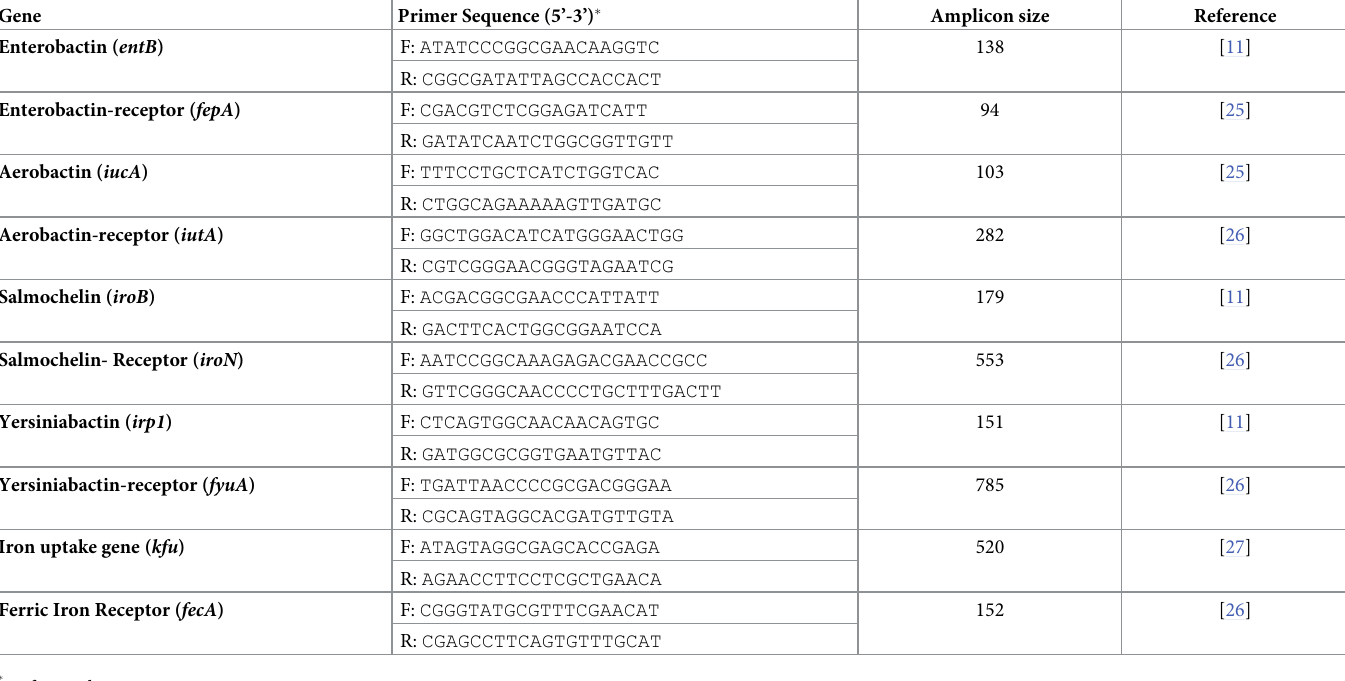
Table 1. List of primer sequences used for PCR amplification of iron acquisition